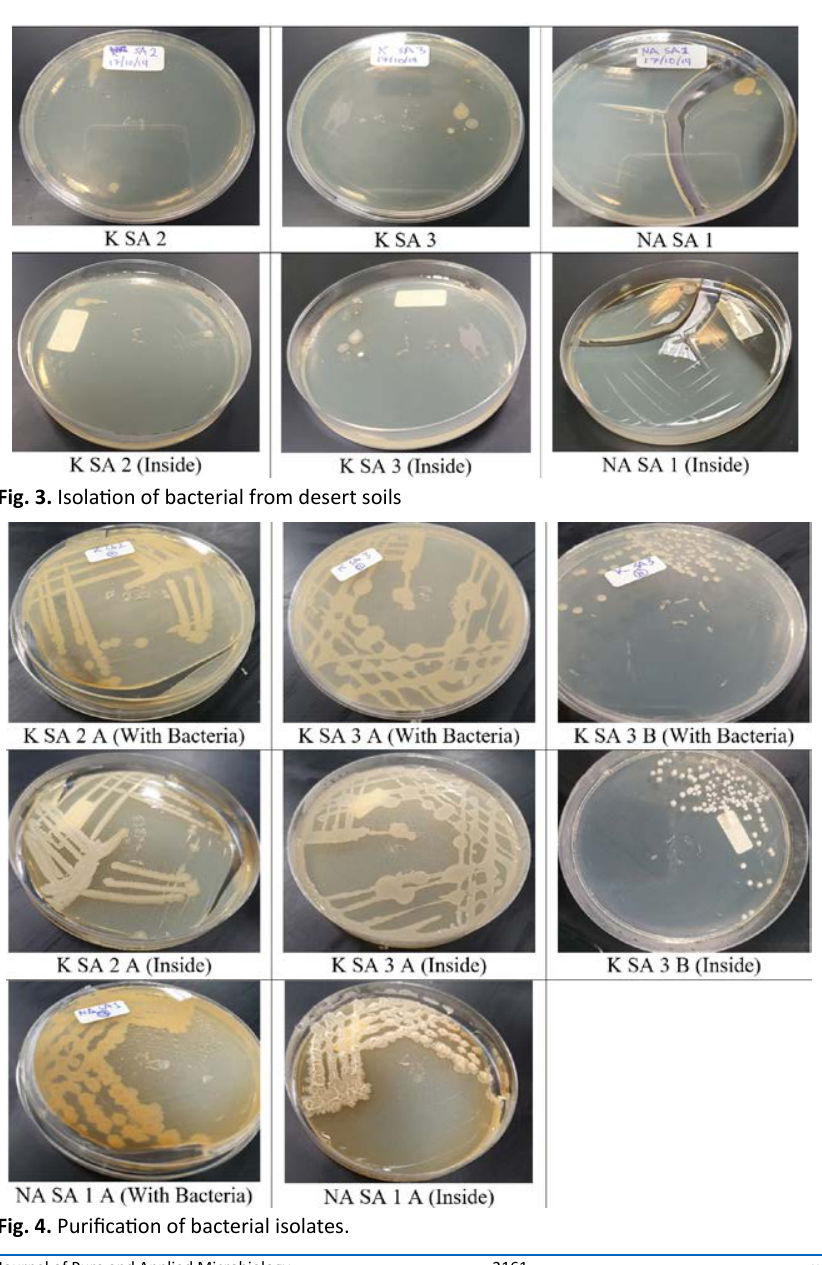
Fig. 4. Purification of bacterial